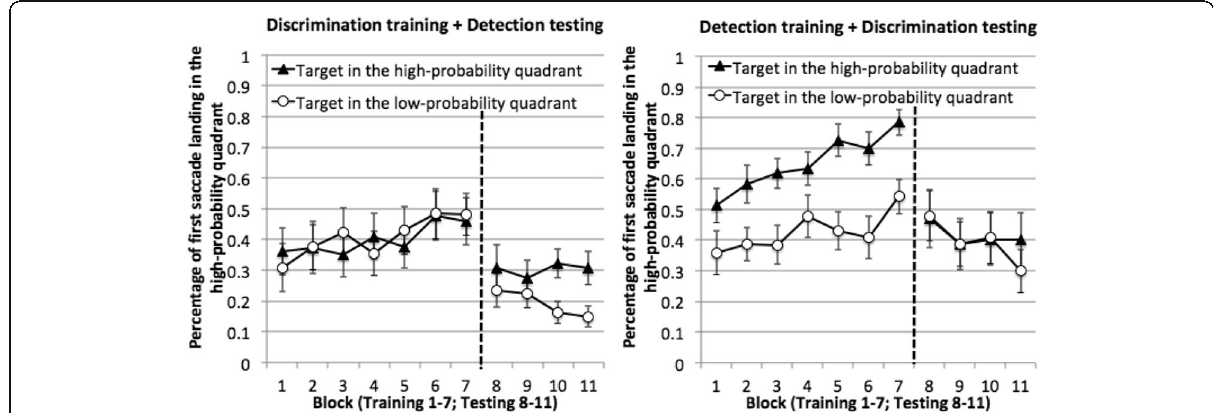
Fig. 7 Direction of the first saccadic eye movement on target-present trials in Experiment 2. Y-axis plots the proportion of trials in which the first saccade was directed toward the high-probability quadrant. Trials were separated depending on where the target was. Left : Participants were trained in the discrimination task and tested in the detection task. Right : Participants were trained in the detection task and tested in the discrim- ination task. Error bars show ±1 S.E. of the